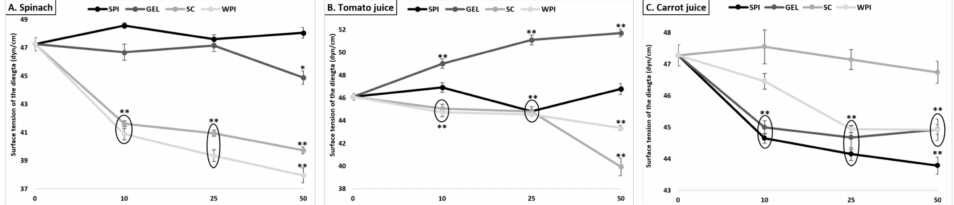
Figure 6. Effect of proteins on the surface tension of the digesta (value of pure water: 71.99